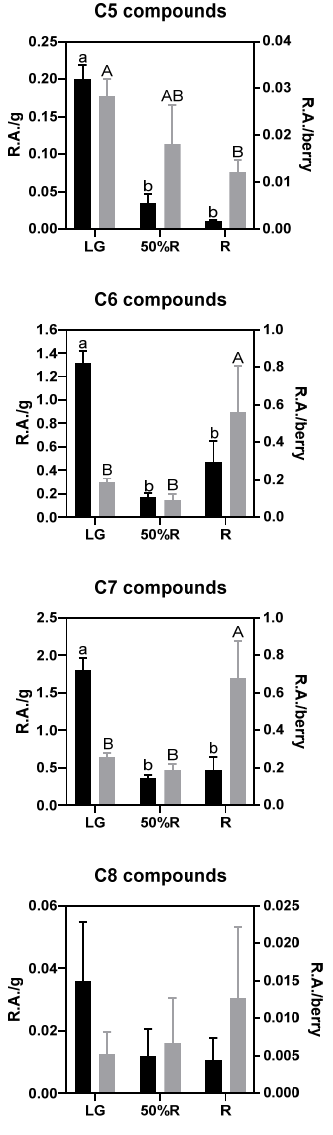
Figure 6. Analysis of volatile aliphatic compounds according to their backbone at stages LG, 50%R, and R. Black bars correspond to the relative areas per g of berry ( left axis ), and grey bars correspond to the relative areas per berry ( right axis ). Different letters indicate statistical differences ( p < 0.05) among ripening stages.